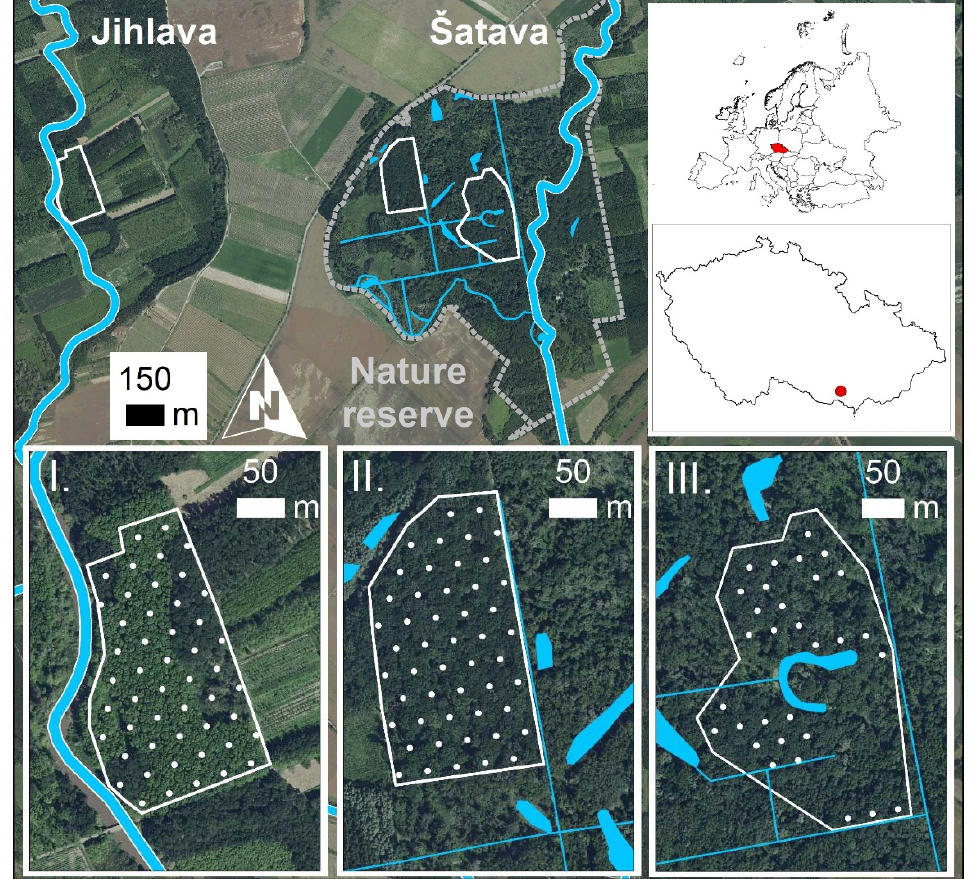
Figure 1. Location of the study area between rivers Jihlava and Šatava and the sampling design at the three study sites ((I) Bedrich, (II) Placek A, and (III) Placek B). Within the Natural Reserve, the blue polygons represent open water bodies; the lines are ditches and channels of the drainage system. The hexagonal point grid within each site indicates the geometrical centers of plots used for soil sampling.